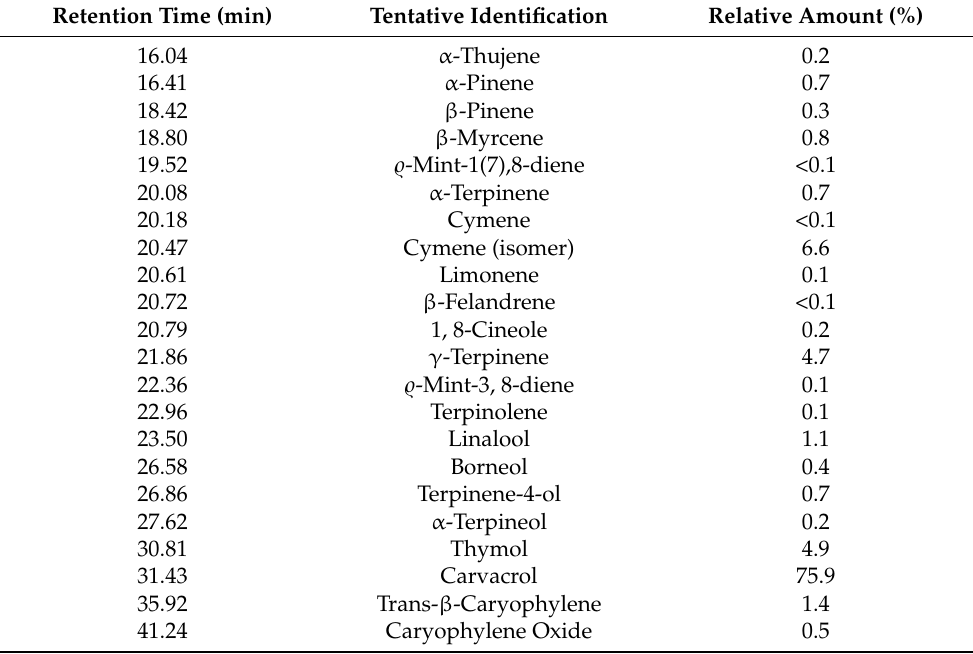
Table 1. Constituents identified in oregano essential oil using GC–MS